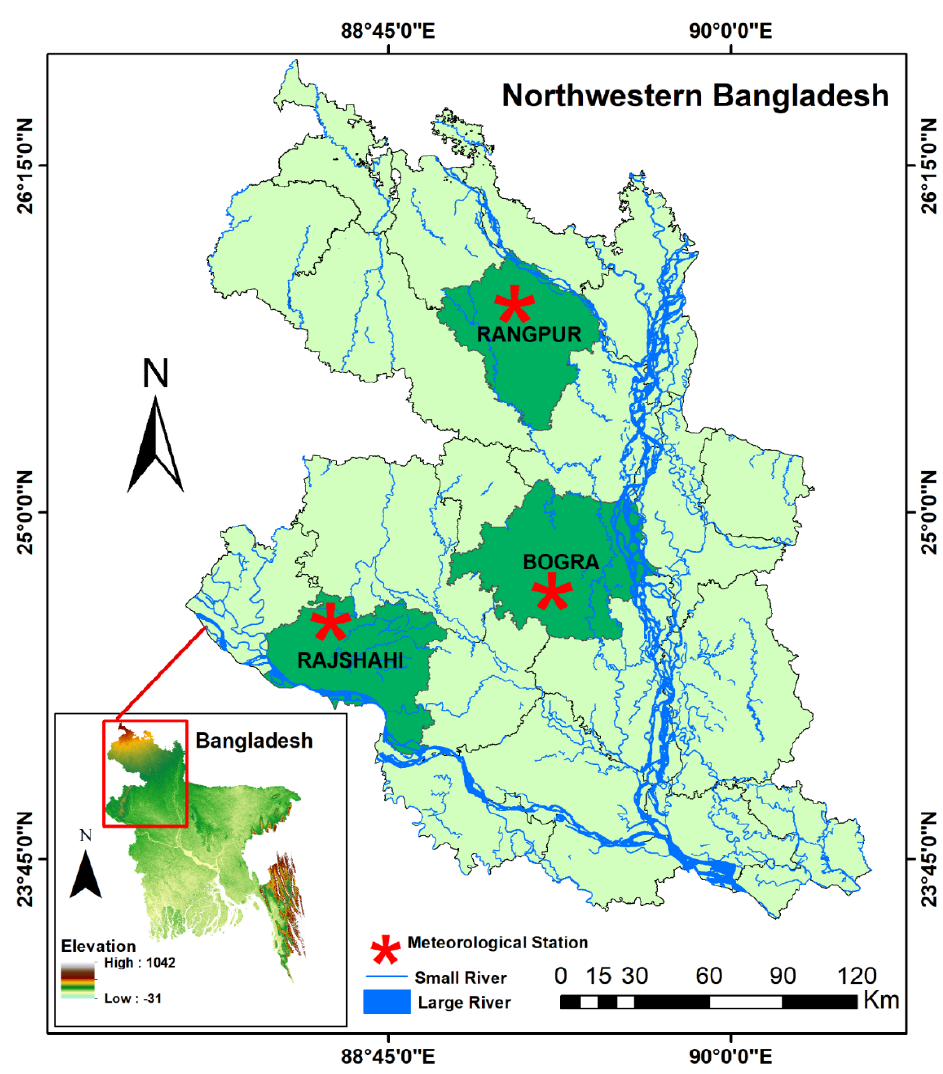
Figure 1. Location of selected stations.